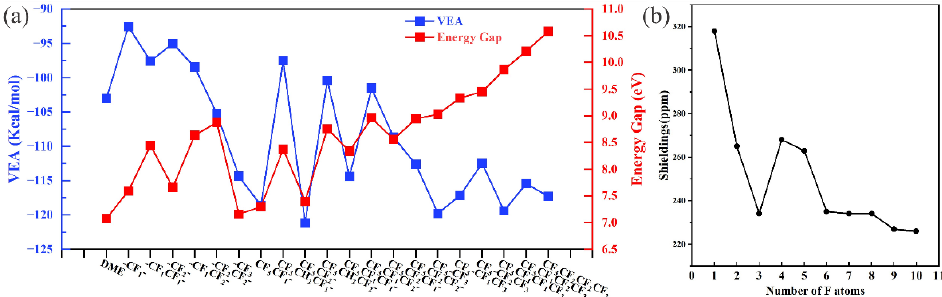
Figure 4. VEA and energy gap of HOMO – LUMO ( a ) and the relationship between absorption peaks (NMR) with F numbers ( b ).